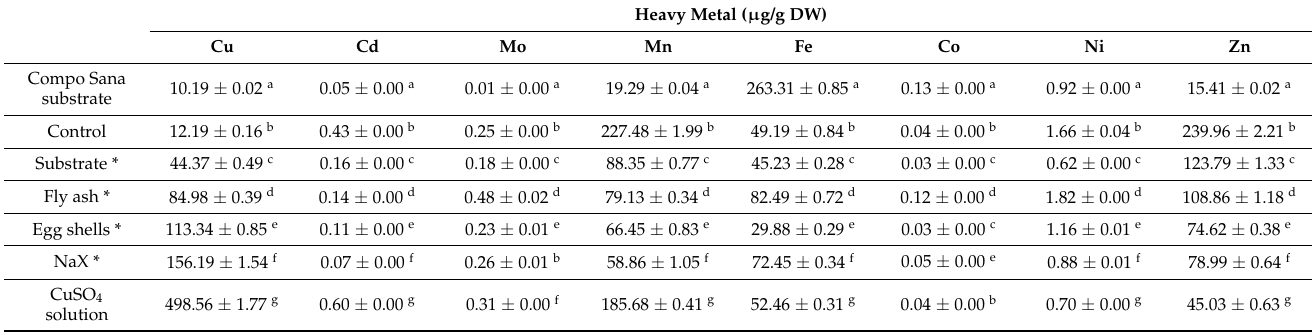
Table 2. Heavy metal content in the cultivated rocket (whole plant).